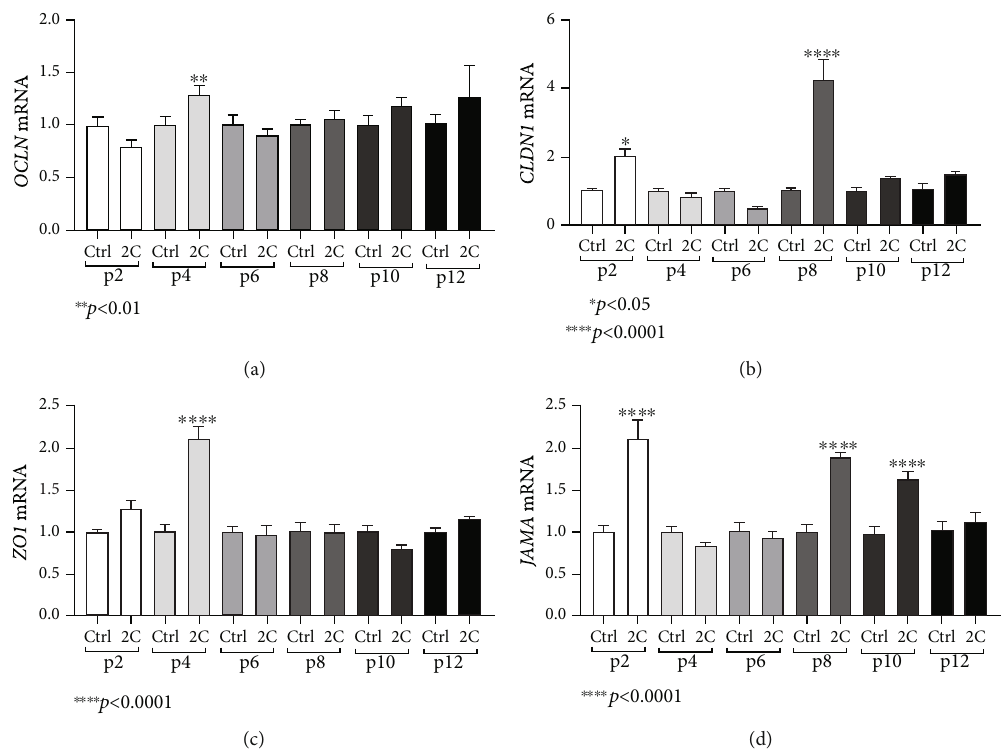
Figure 7: Epithelial responses to proin fl ammatory cytokines decrease during passaging. IL-1 α and TNF- α (2C) induced the mRNA expression of OCLN in passage 4 (a), CLDN1 in passages 2 and 8 (b), ZO1 in passage 4 (c), and JAMA in passages 2, 8, and 10 (d). Concentrations of cytokines used: IL-1 α 5ng/ml, TNF- α 50ng/ml. All experiments were performed in triplicate. The gene expression of each studied gene was normalized against GAPDH gene expression in the same sample using the 2 - ΔΔ Ct method. In every passage, expression levels of treated organoids were normalized against those of the control ones. Data are presented as the mean ± standard error of the mean ð SEM Þ